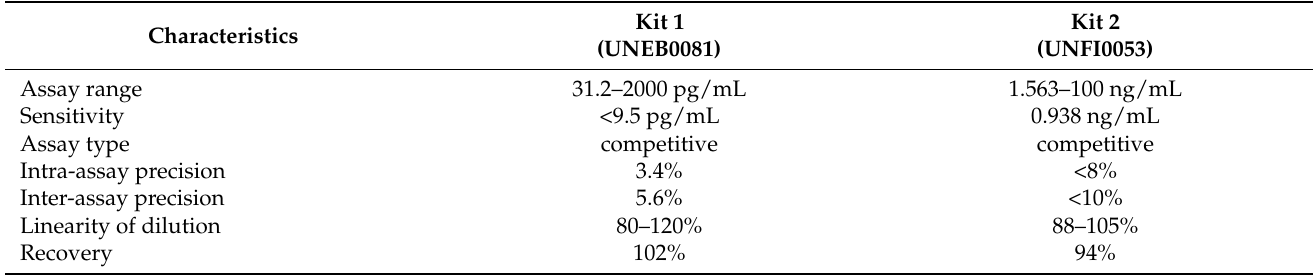
Table 1. Characteristics of the tested ELISA kits and manufacturers’ validation criteria in blood